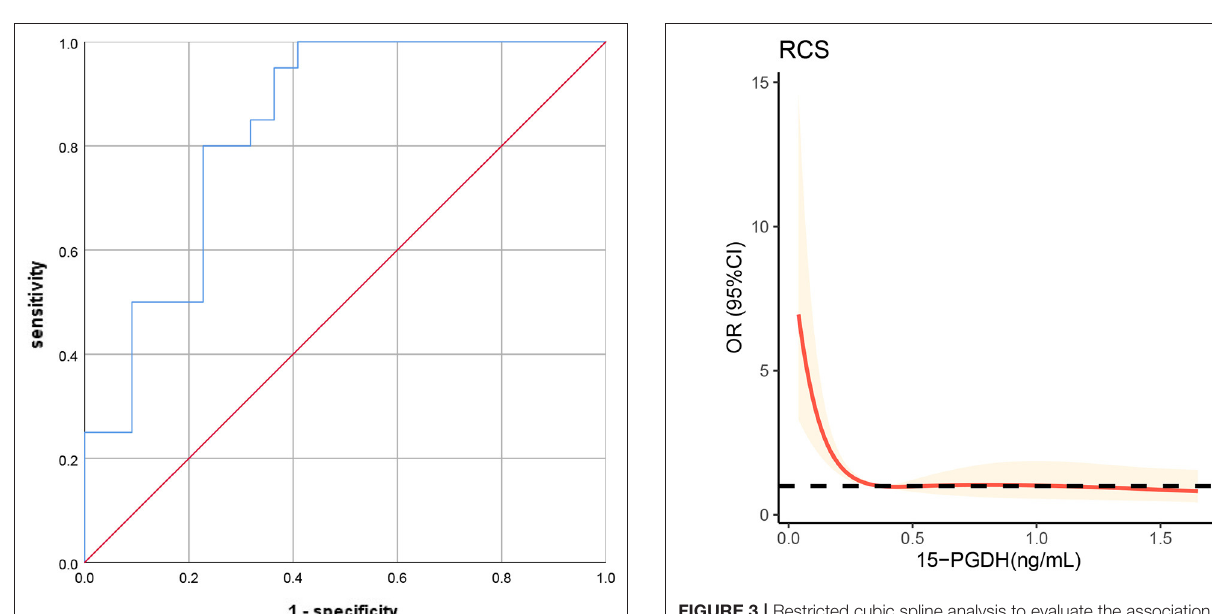
FIGURE 3 | Restricted cubic spline analysis to evaluate the association between serum 15-PGDH levels and risk of SAP. SAP, stroke-associated pneumonia; OR, odds ratio; 95%CI, 95% confidence interval; 15-PGDH, 15-hydroxyprostaglandin dehydrogenase. TABLE 3 | Patient characteristics with severe SAP and mild